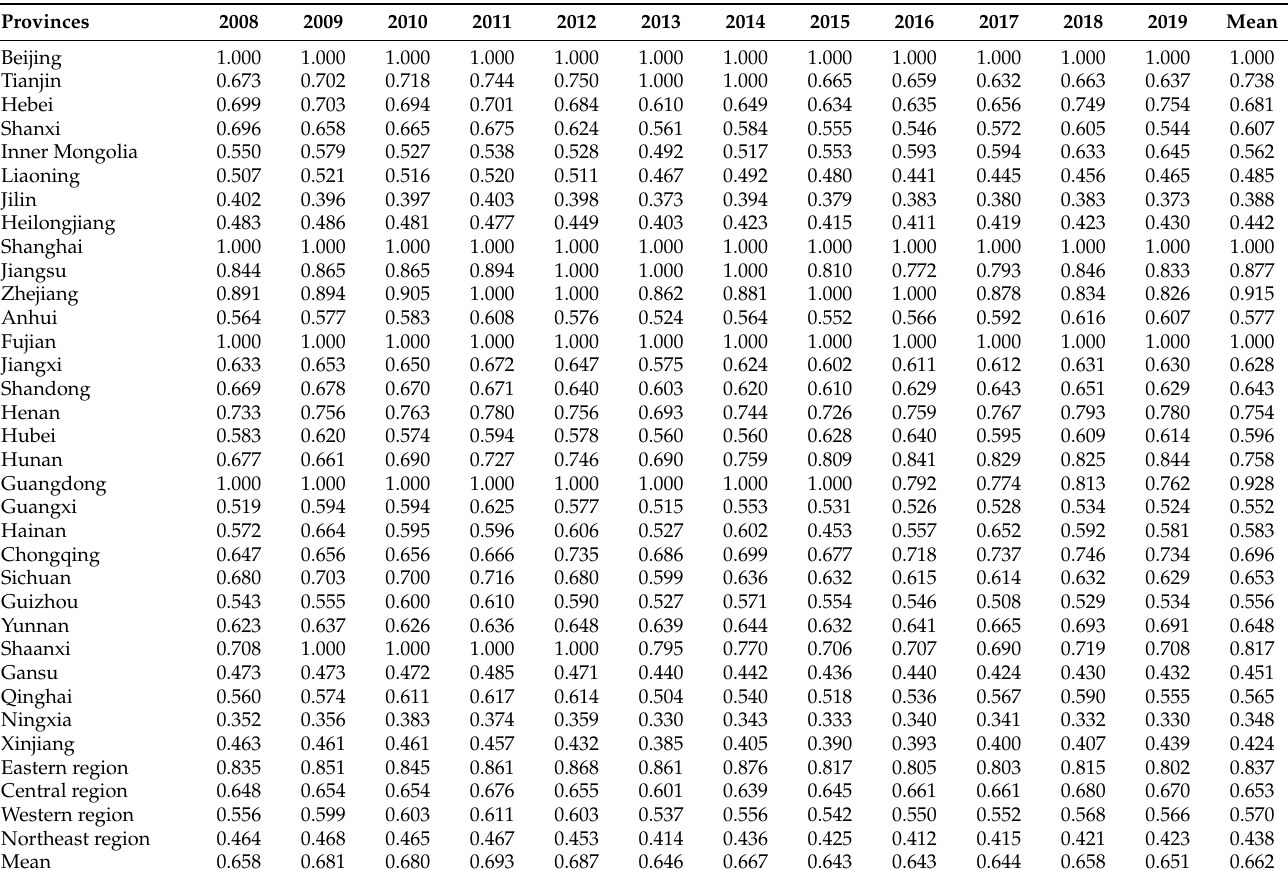
Table 3. The values of EE for 30 provinces in China